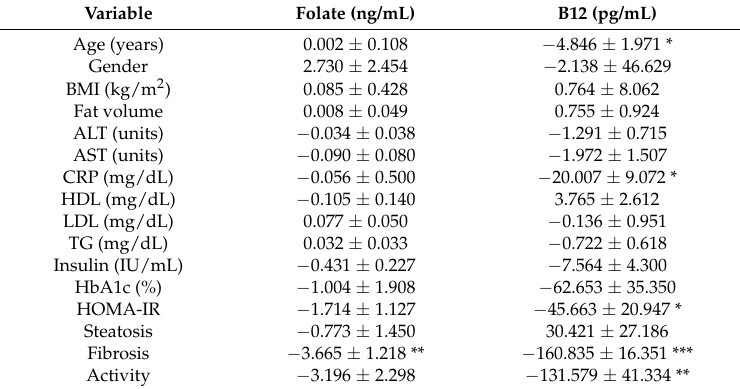
Table 2. Univariate regression analysis for each vitamin studied in the present